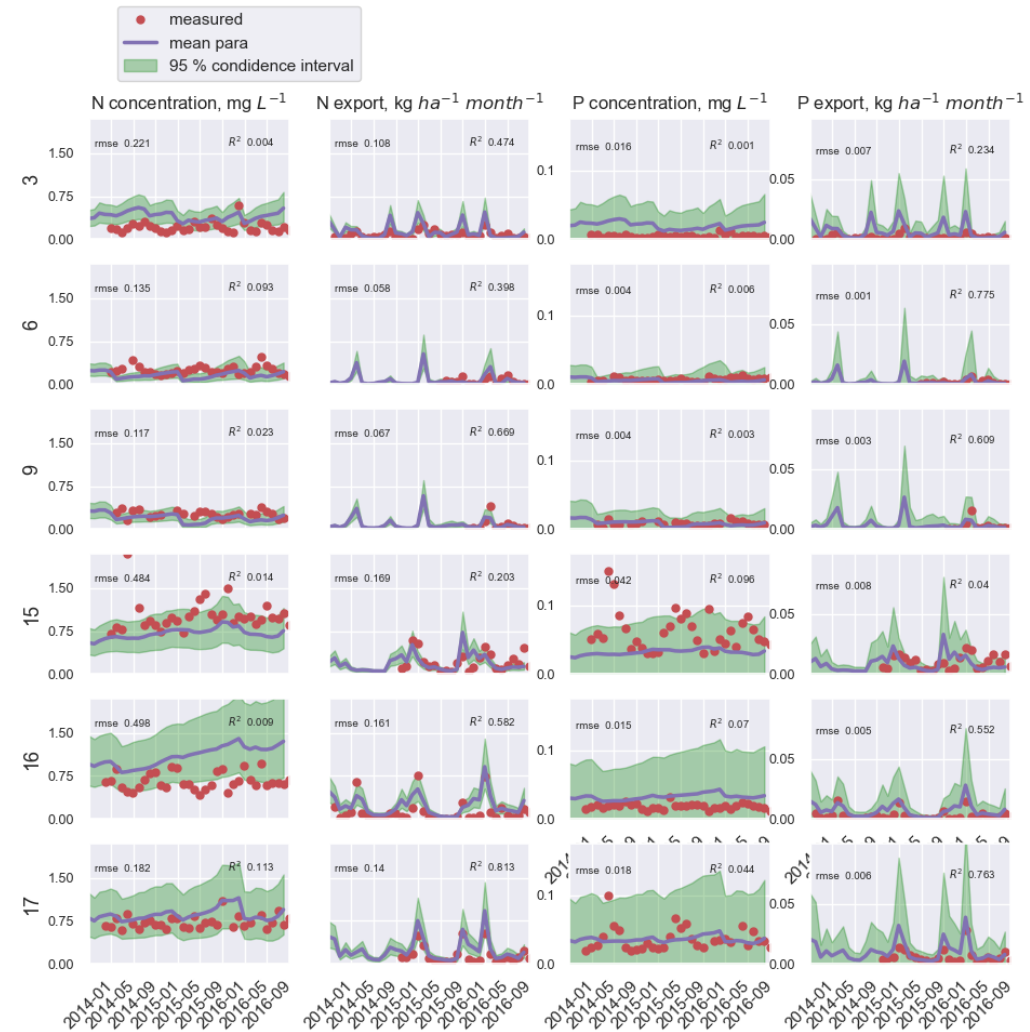
Figure 4. Observed nitrogen (N) and phosphorus (P) stream water concentration and export in the independent test catchments (red dots, catchment number as y label), and modelled values using immobilization parameters derived from catchment properties (blue